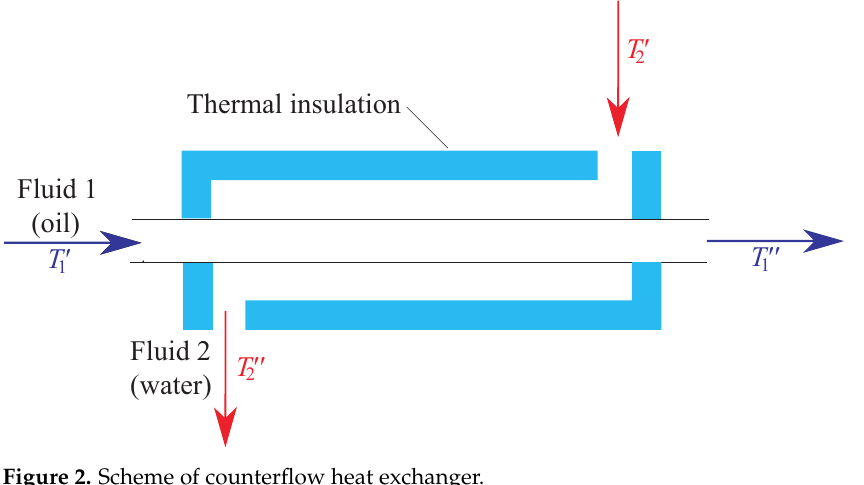
Figure 2. Scheme of counterflow heat